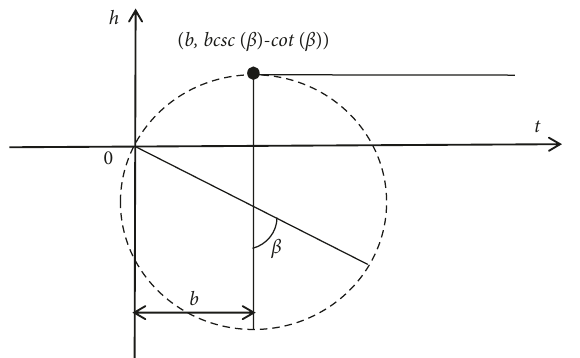
Figure 3: Schematic diagram of cross-section function (circular